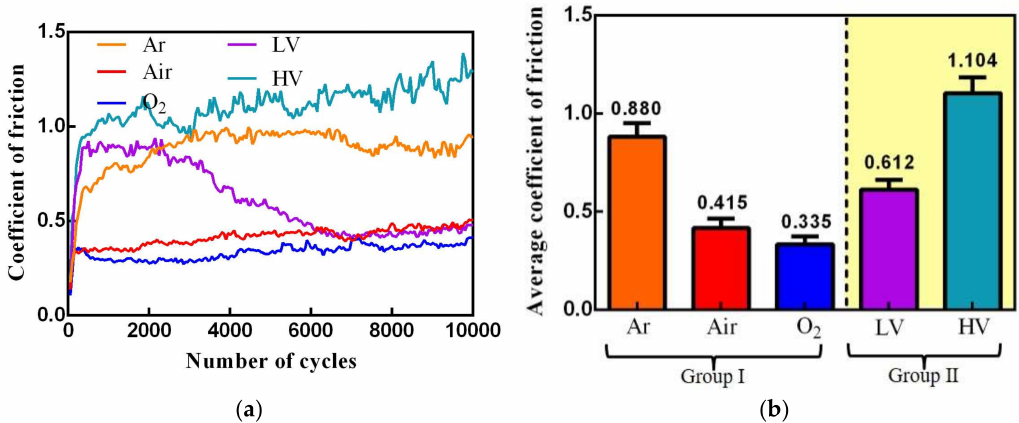
Figure 2. The COF versus cycle number ( a ) and the average COF under different environment conditions ( b ).